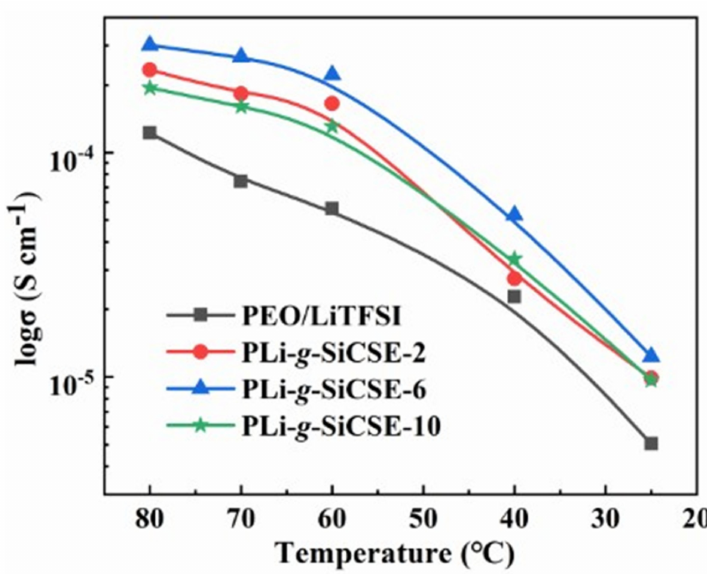
Figure 8. Ionic conductivity plots of the prepared CSEs membranes containing PEO/LiTFSI and different amounts of PLiSSPSI- g -SiO 2